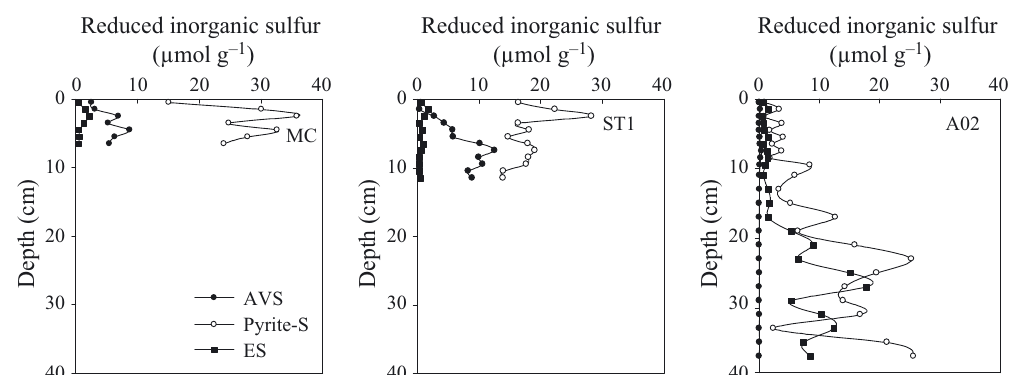
Fig. 8. Vertical distribution of reduced inorganic sulfur in sediments of Sanggou Bay and the Yellow Sea (see Fig. 1 for station Table 2. Principal component analysis for surface sediments of Sanggou Bay. AVS: acid-volatile sulfide, ES: elemental sulfur, RIS: reduced inorganic sulfur, OM: organic matter